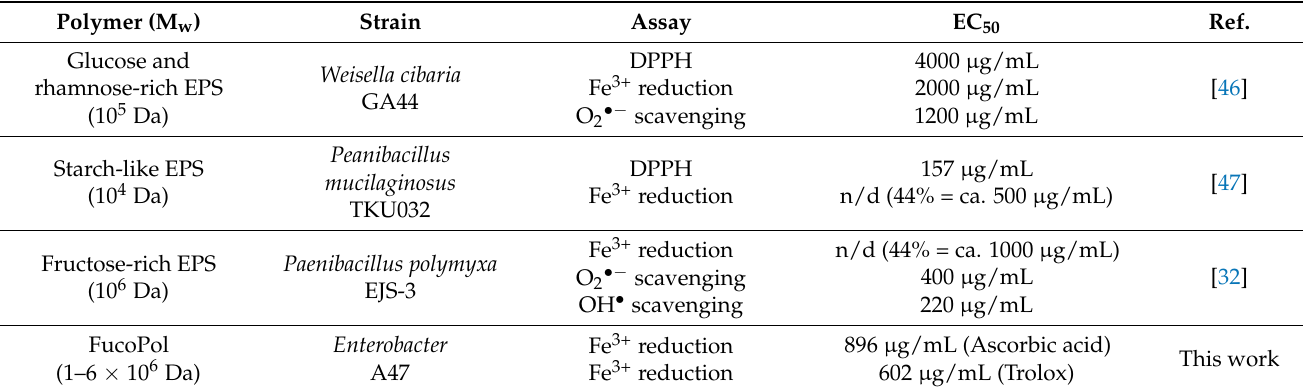
Table 1. Literature collection of antioxidant activity observed in polysaccharides from different sources. Different experi- ments represent different sources of data that are not fully comparable. Fe 3+ reduction assays refer to contrasts with ascorbic acid, unless referred